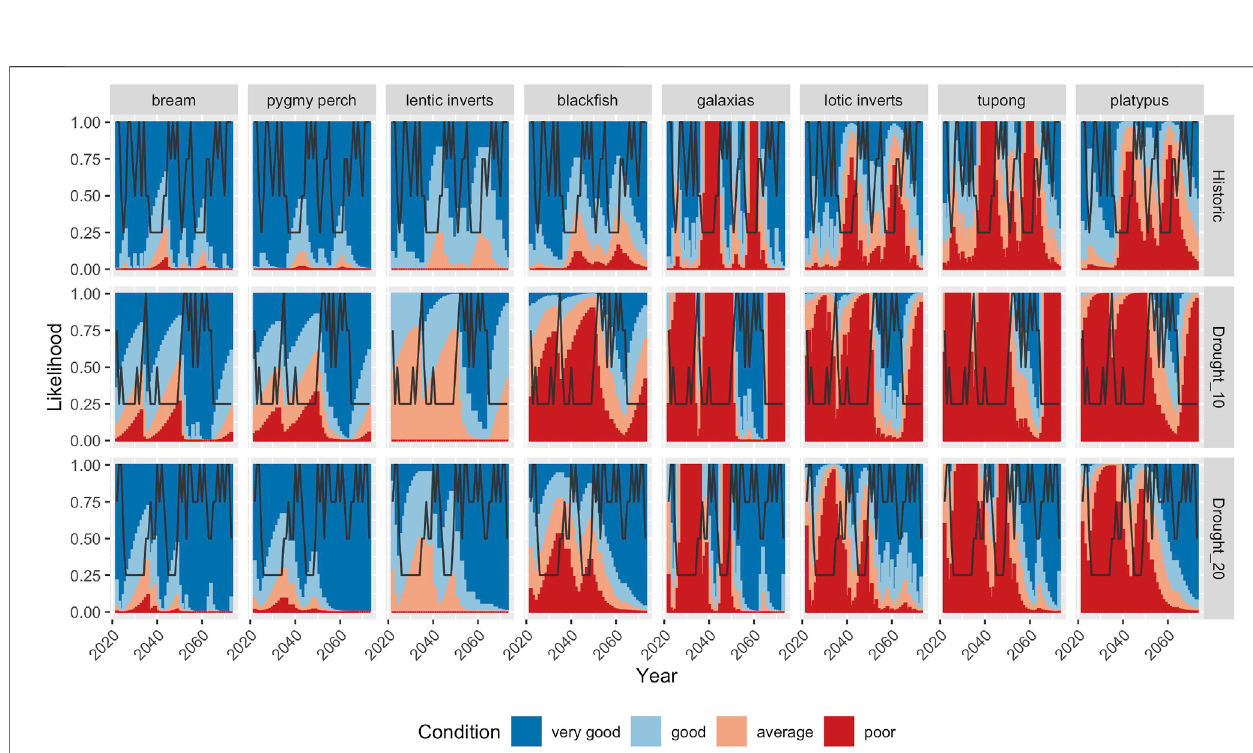
FIGURE 5 | Projected trends in condition of each population/community under a single hypothetical hydrologic sequence produced under each climate scenario: historical sequence (top), 10% increase in drought persistence (middle) and 20% increasein drought persistence (bottom). The black line shows the runoff class in each year; 0.25 = “ Drought ” , 0.5 = “ Dry ” , 0.75 = Wet, and 1 = “ Very wet ” .